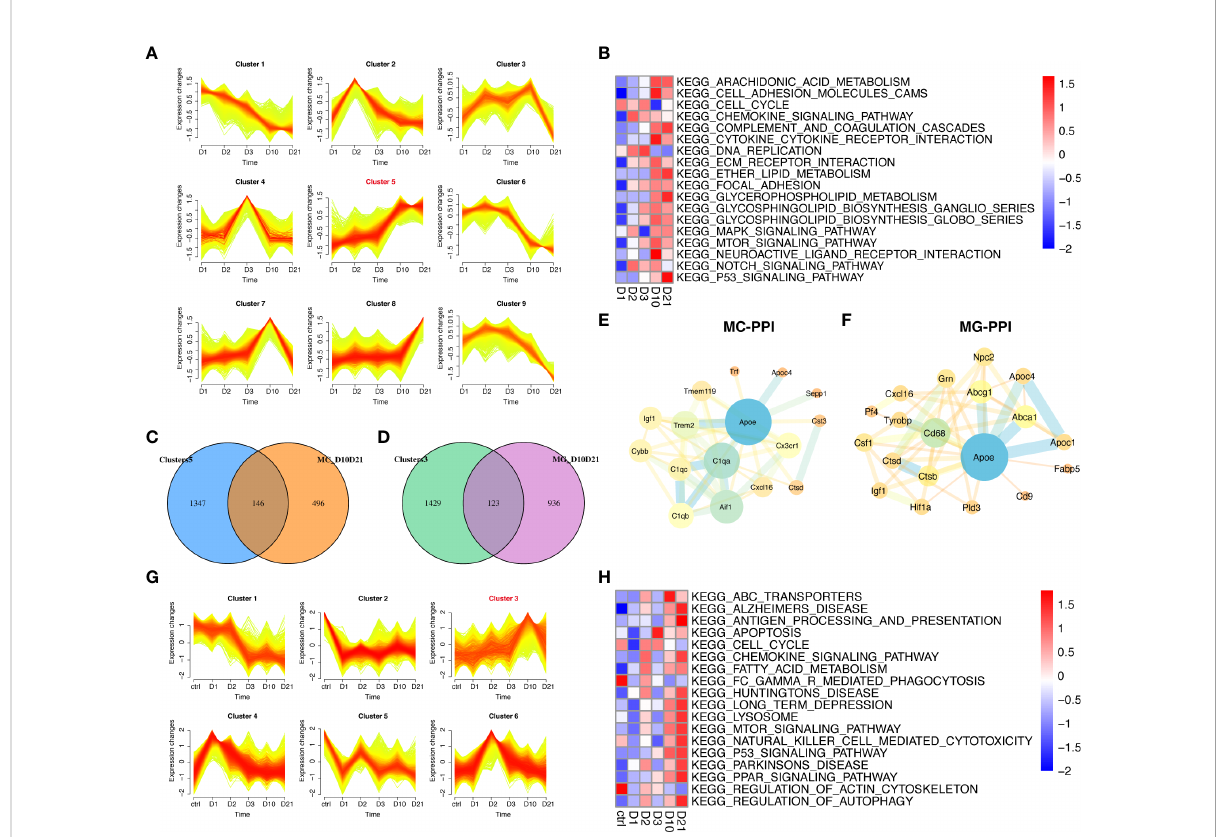
FIGURE 5 Temporal clustering analysis of macrophages and microglia following spinal cord injury (SCI). (A) Temporal clustering analysis of macrophages following SCI. (B) Heatmap showing gene set variation analysis (GSVA) of genes in cluster fi ve and c2 KEGG gene sets. (C) Venn diagram showing an overlap between genes in cluster fi ve and genes that were differentially expressed between macrophages sampled 10 days post injury (dpi) and those sampled 21 dpi. (D) Venn diagram showing an overlap between genes in cluster three and genes that were differentially expressed between microglia sampled 10 dpi and those sampled 21 dpi. (E) Protein-protein interaction (PPI) network showing an overlap of genes in cluster fi ve and genes that were differentially expressed in macrophages sampled 10 dpi and those sampled 21 dpi. (F) PPI network showing the overlap between genes in cluster three and genes that were differentially expressed between microglia sampled 10 dpi and those sampled 21 dpi. (G) Temporal clustering analysis of microglia following SCI. (H) Heatmap showing GSVA of genes in cluster three and the c2 KEGG gene